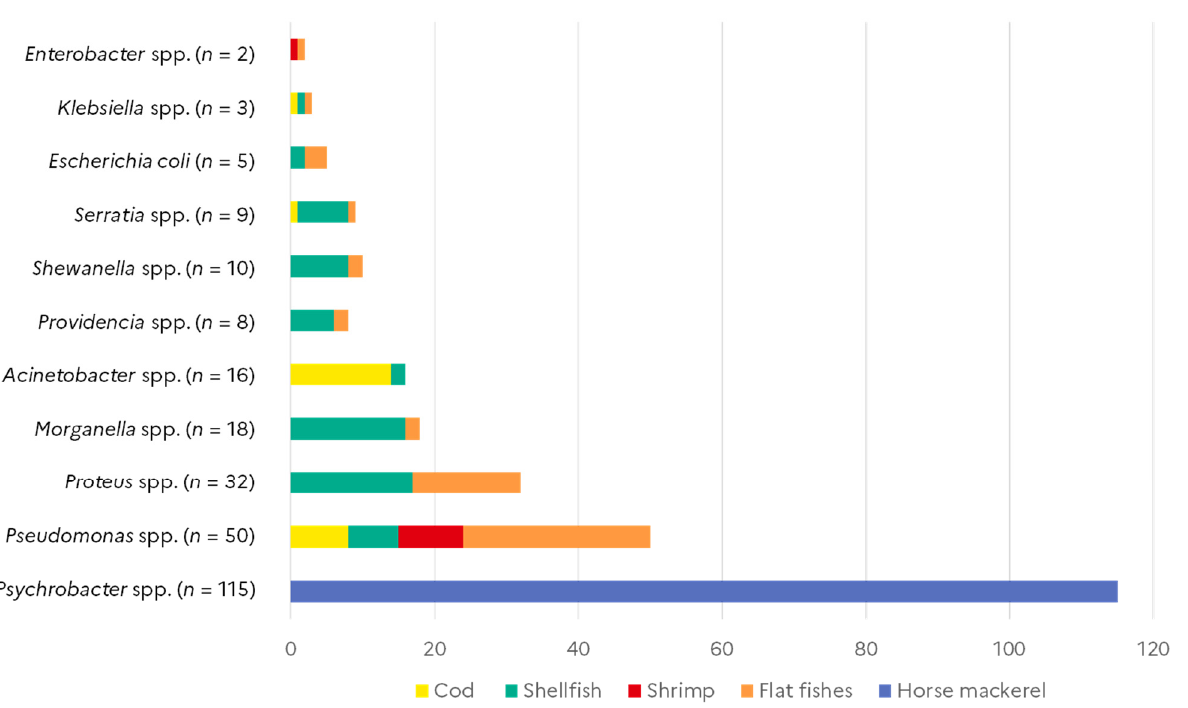
Figure 1. Bacterial isolates studied and their seafood sources.